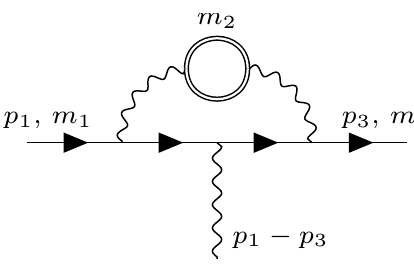
Figure 25. Generic NNLO diagram with photon vacuum polarisation insertion in the vertex correction. The single fermionic line represents the leptonic current of mass m , the double solid 1 line represents leptonic loop of mass m and the wavy line represents 2